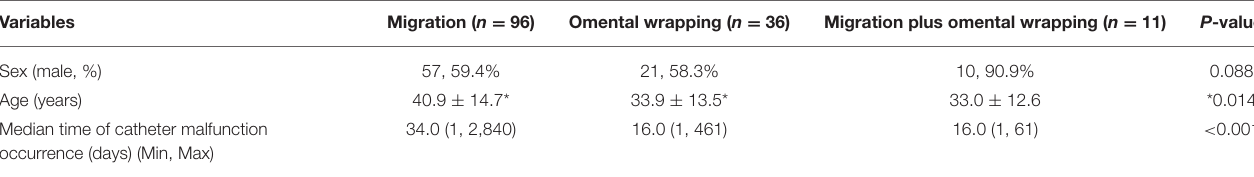
TABLE 4 | Clinical features of PD catheter